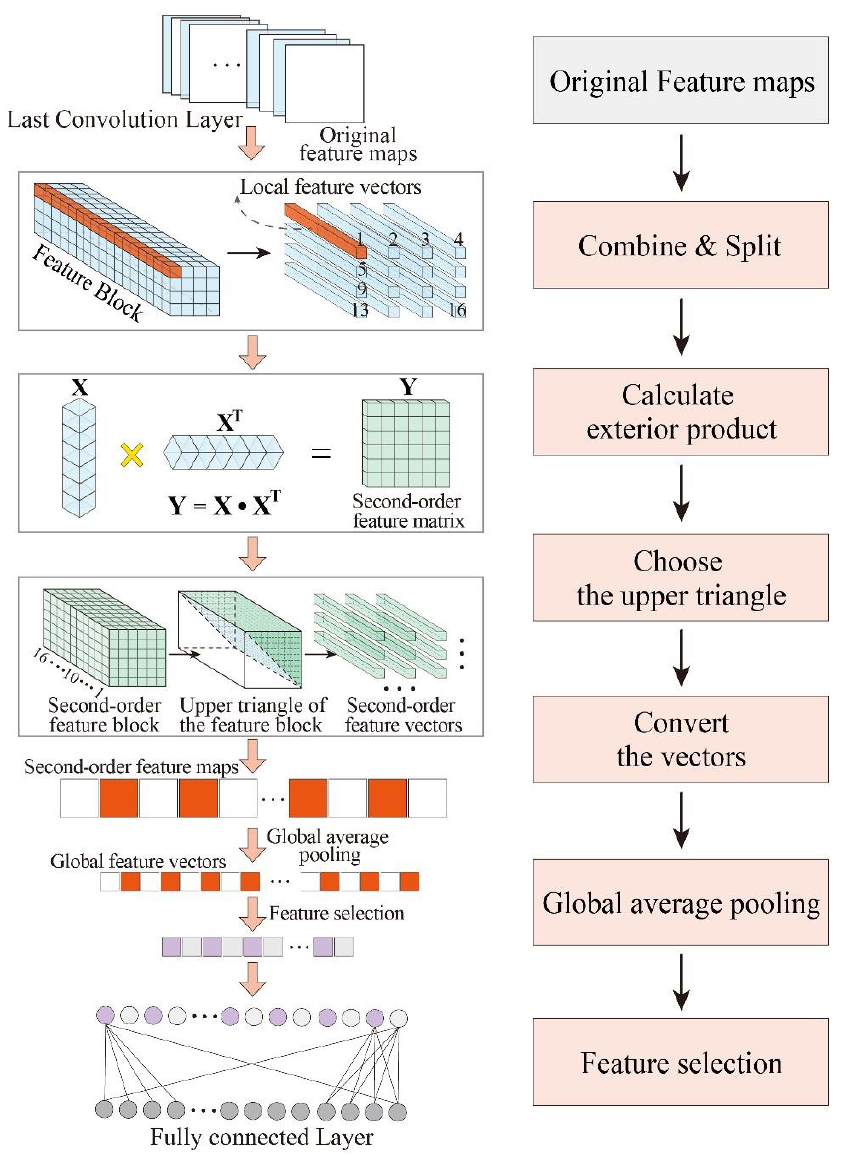
Figure 9. The process of the second-order pooling method.